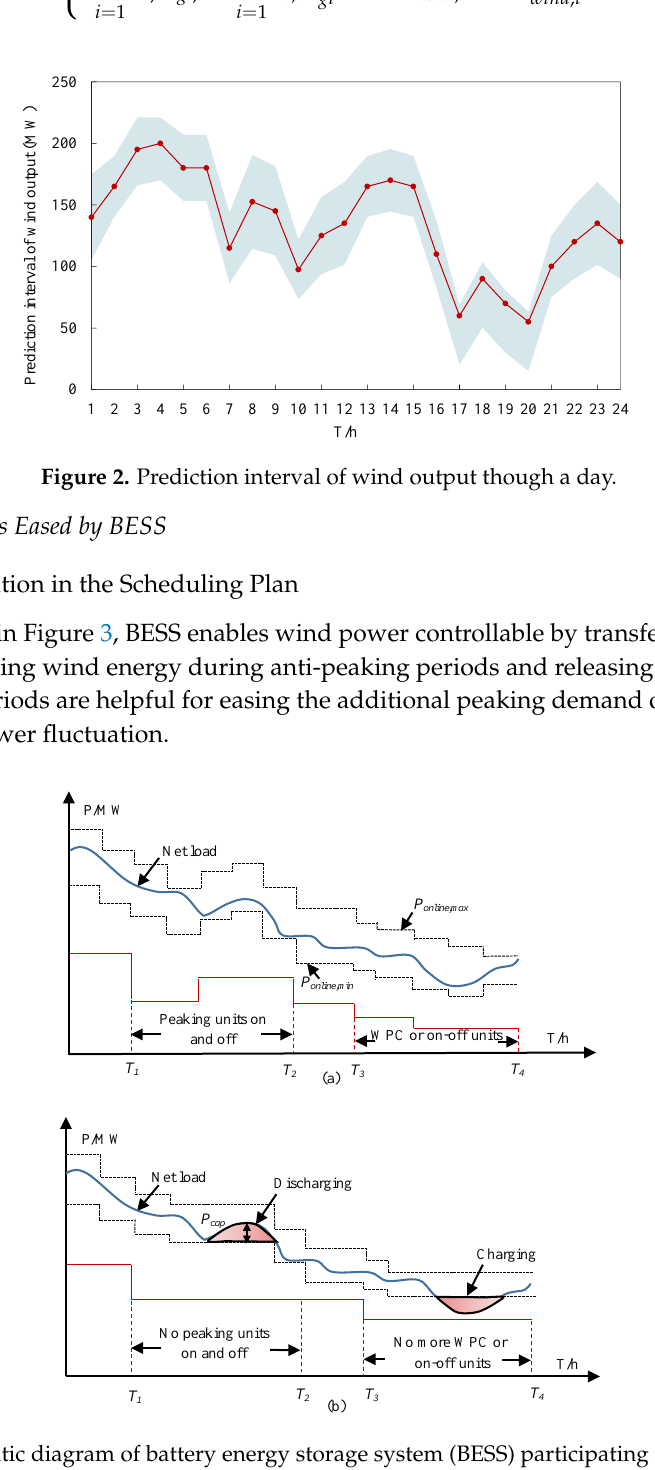
Figure 3. Schematic diagram of battery energy storage system (BESS) participating in the scheduling; ( a ) wind power integration without BESS; and, ( b ) wind power integration with BESS. BEES: battery energy storage system; WPC: wind power